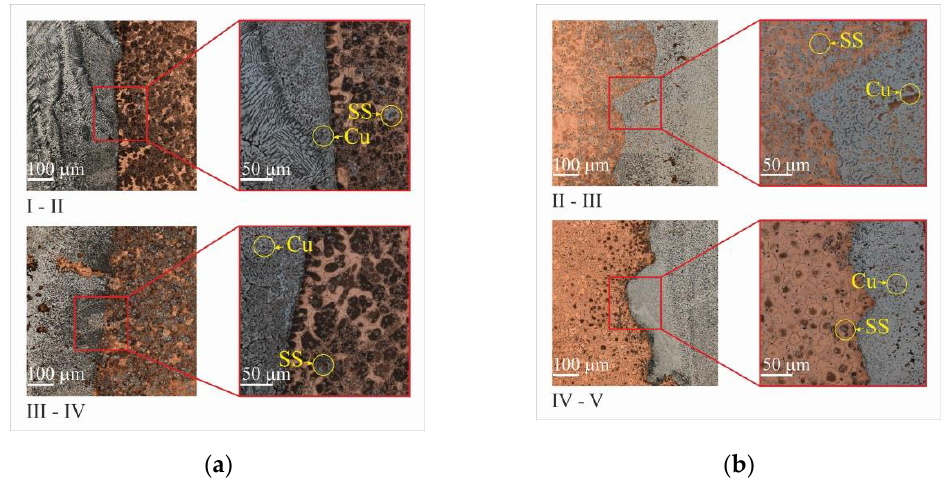
Figure 12. Optical microscopy of boundary of “SS–Cu” ( a ) and “Cu–SS” ( b ) in bimetal laminate macrocomposite produced by electron beam additive manufacturing.